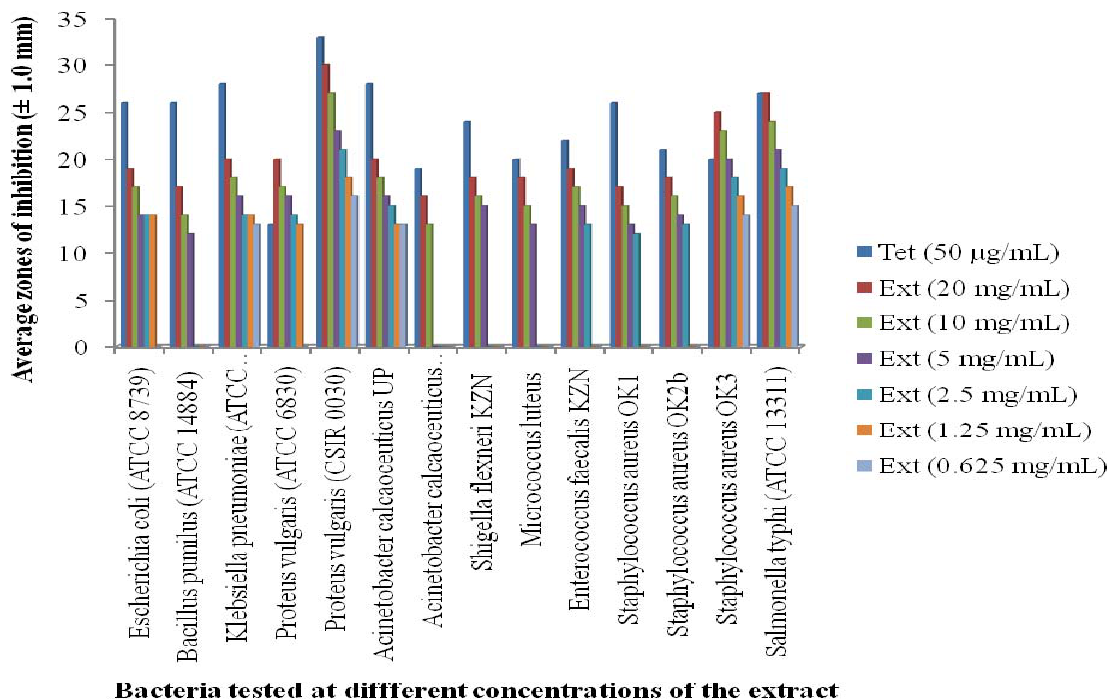
Key: Tet represents Tetracycline; Ext represents